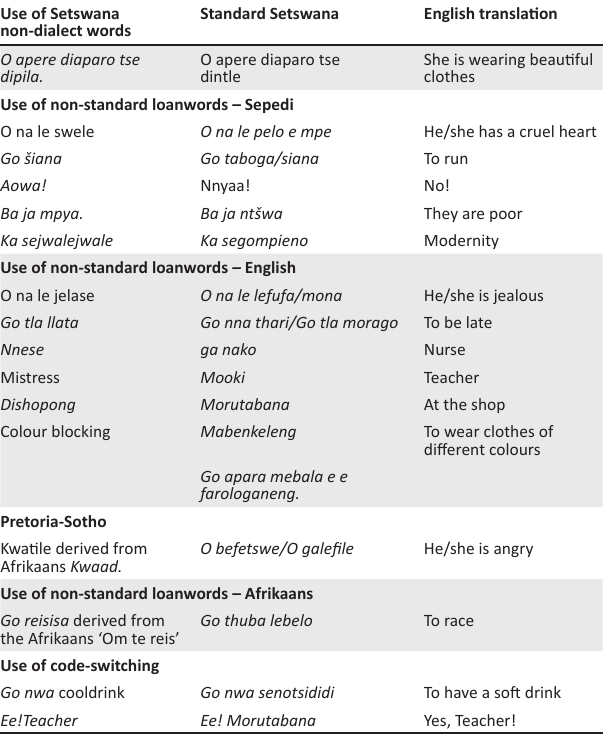
TABLE 1: Sociolinguistic effects on language proficiency in teaching idioms. Use of Setswana Standard Setswana English translation non-dialect words